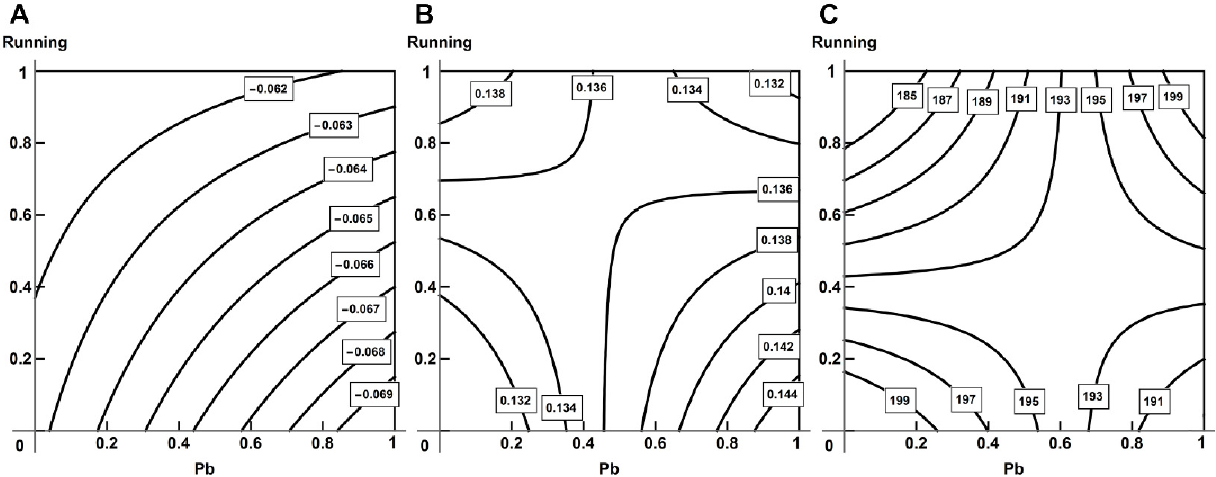
Figure 12. Variability of combined action of running and lead intoxication on ( A ) isoline amplitude (2 lead, opposite action), ( B ) amplitude T (2 lead, complicated picture: from subadditive action at low doses of lead and exercise, through antagonism, to synergism at high doses), ( C ) inspiratory time (complicated picture: same as in ( B )). Regression equations are y = − 0.063 − 0.007 x 1 + 0.002 x 2 + 0.006 x 1 x 2 for ( A ), y = 0.127 + 0.019 x 1 + 0.013 x 2 − 0.028 x 1 x 2 for ( B ) and y = 202.7 − 14.283 x 1 − 22.568 x 2 + 35.570 x 1 x 2 for ( C